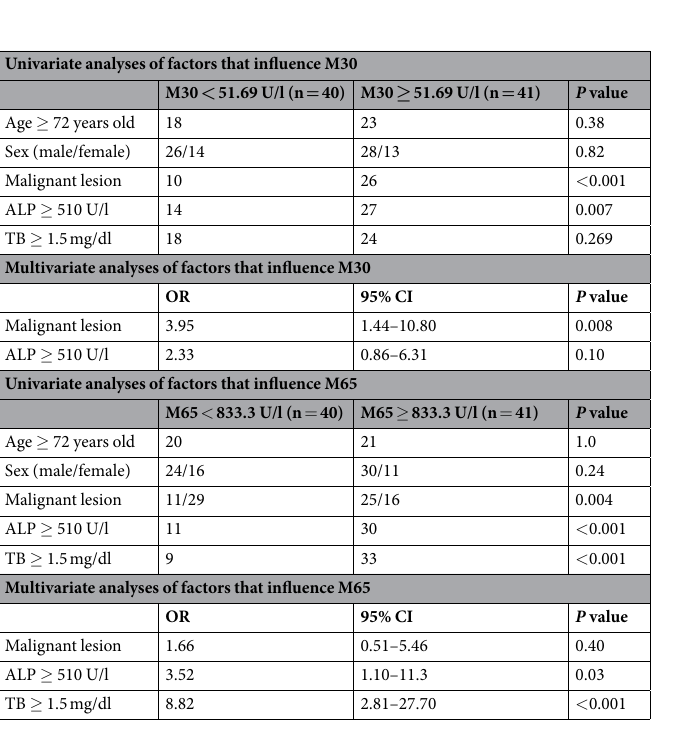
Table 3. Factors that influence M30 or M65. ALP, alkaline phosphatase; TB, total